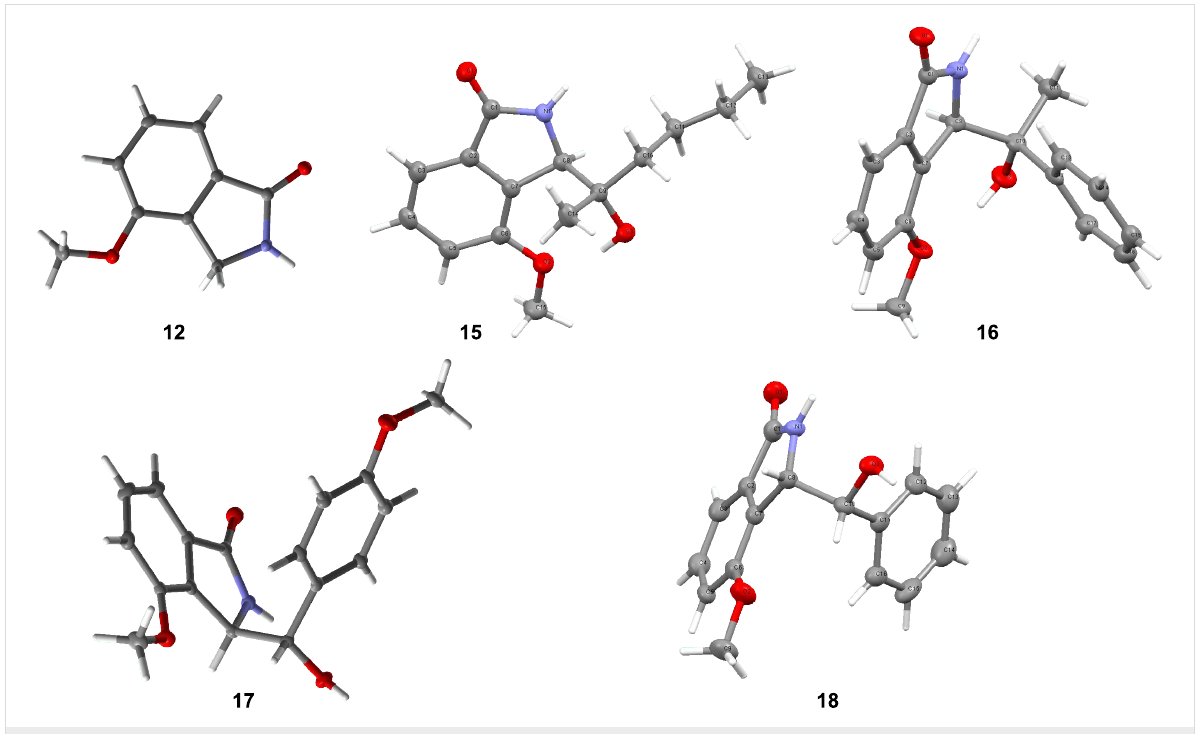
Figure 2: X-Ray crystal structures of crystallized compounds 12 and 15 – 18 .